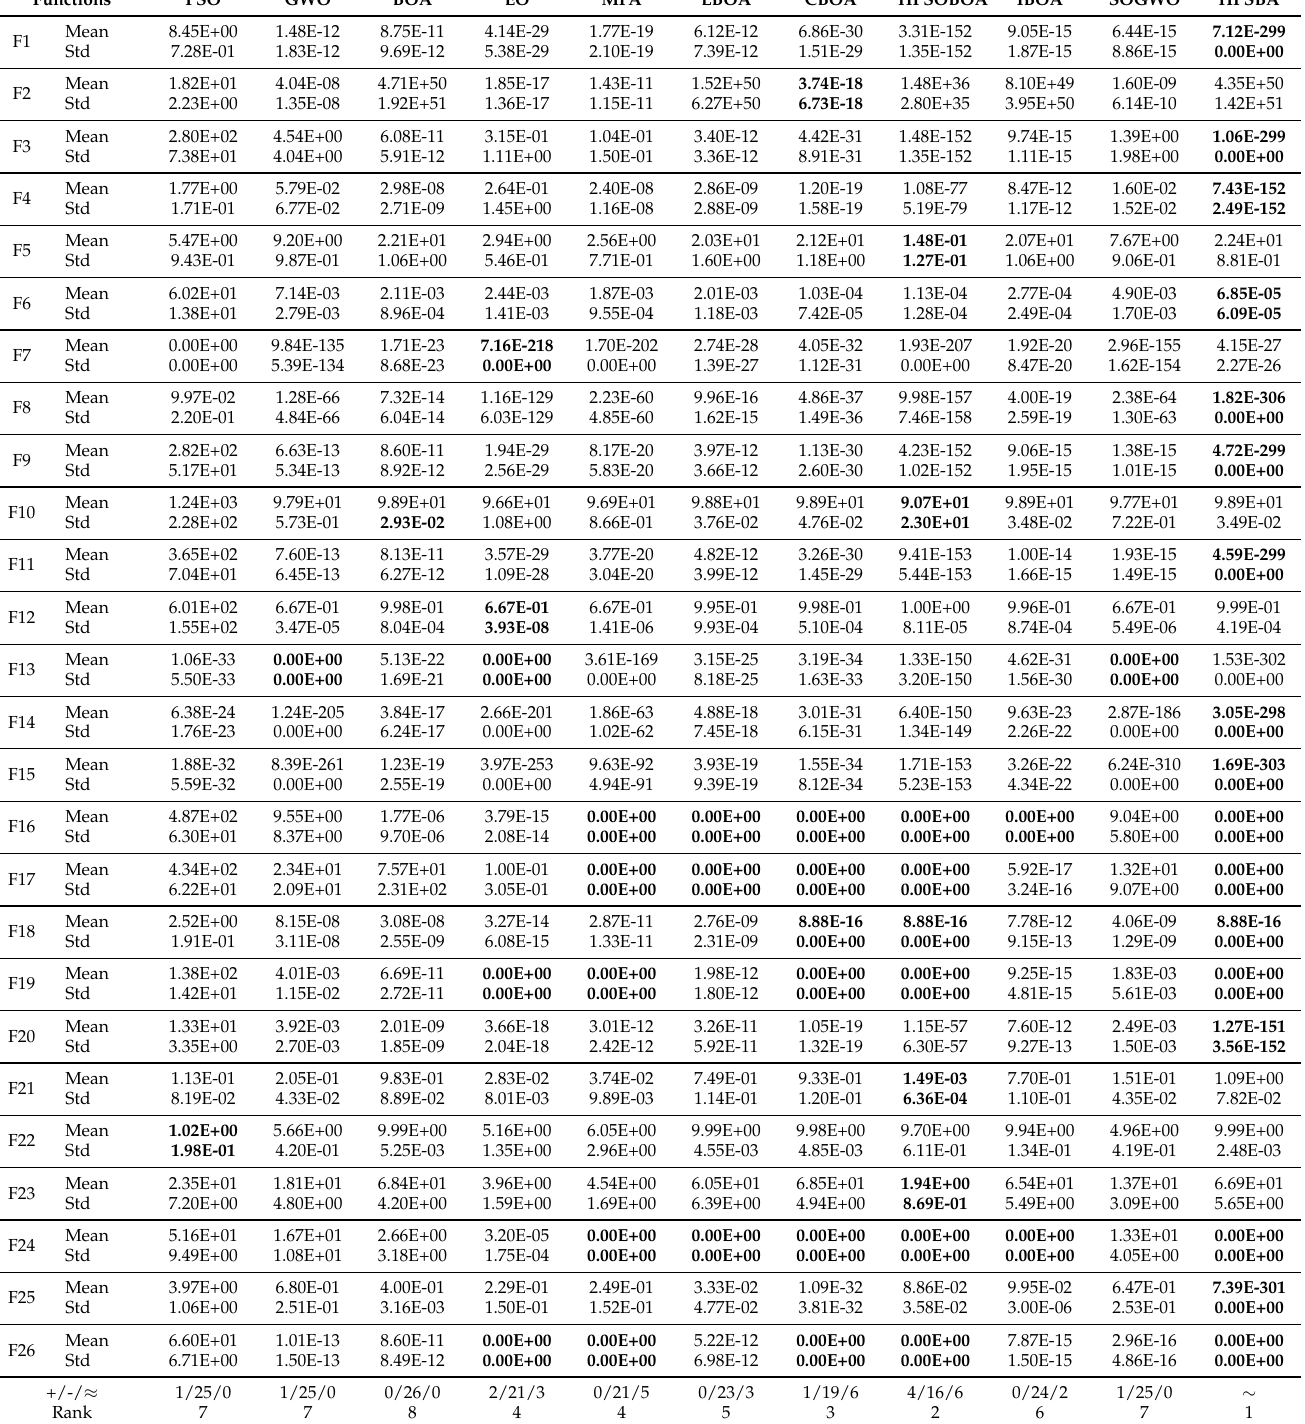
Table 5. Comparison results of eleven algorithms: Dim =